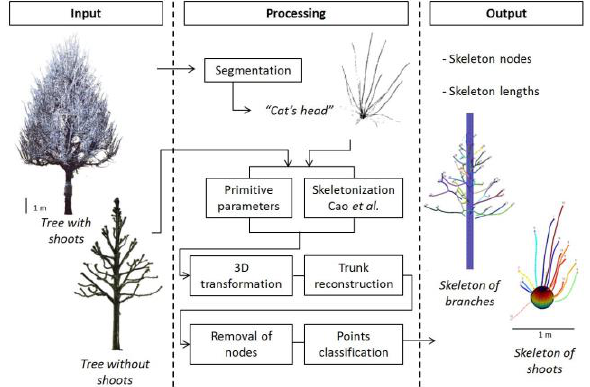
Figure 2. Concept of the 3D tree reconstruction processing chain